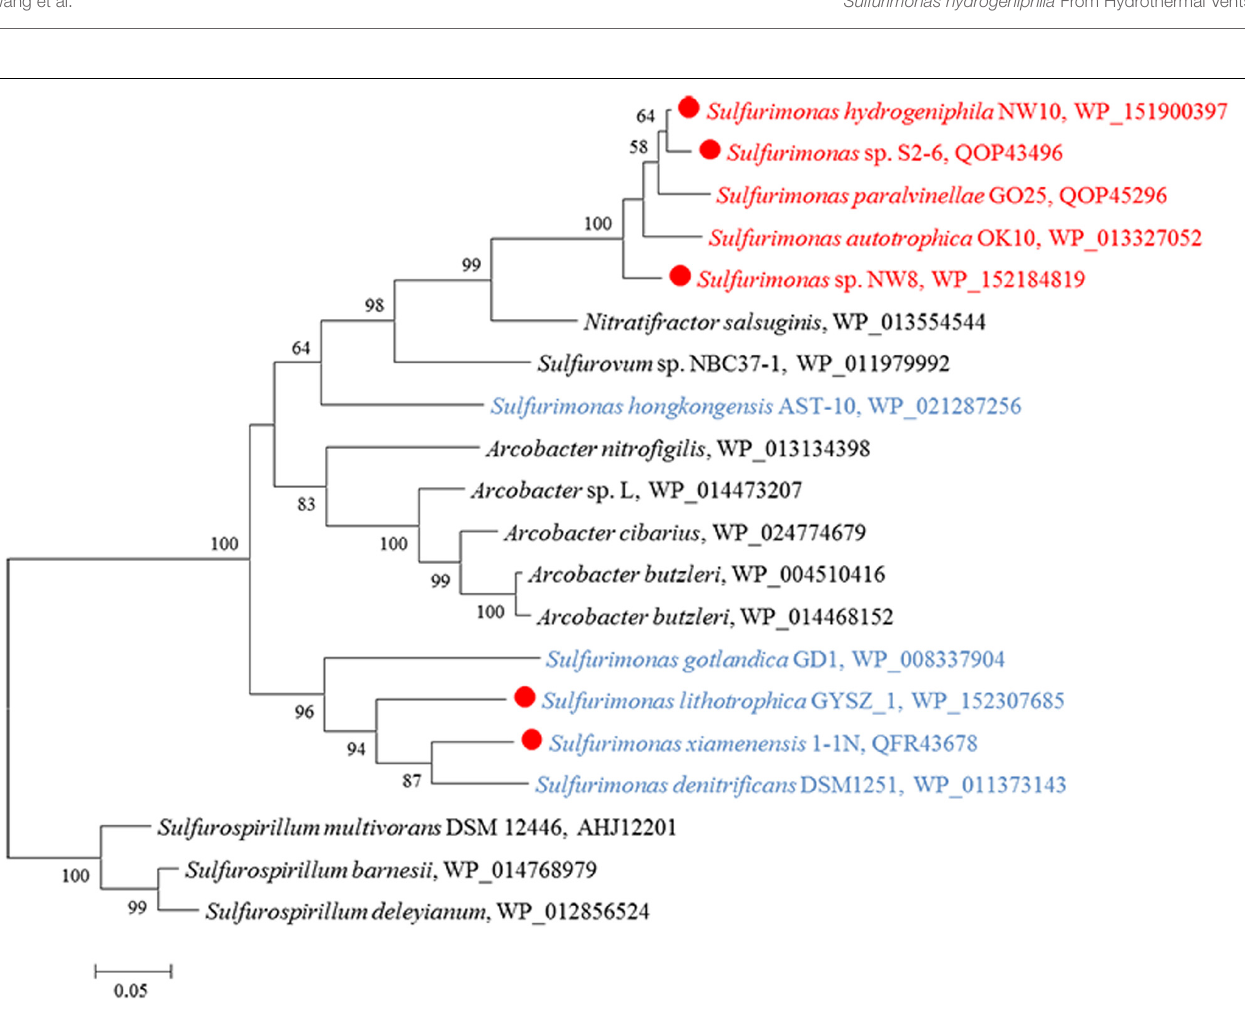
FIGURE 7 | Maximum likelihood phylogenetic tree of the NapA protein sequences derived from Sulfurimonas strains and other representative species within the class Campylobacteria . Bootstrap values indicated at each node are based on a total of 1,000 bootstrap replicates. Branch node values below 50% are not shown. The solid red circles represent our own isolated strains. Isolation sources of Sulfurimonas species are indicated in different font colors: red, hydrothermal environments; blue, marine non-vent